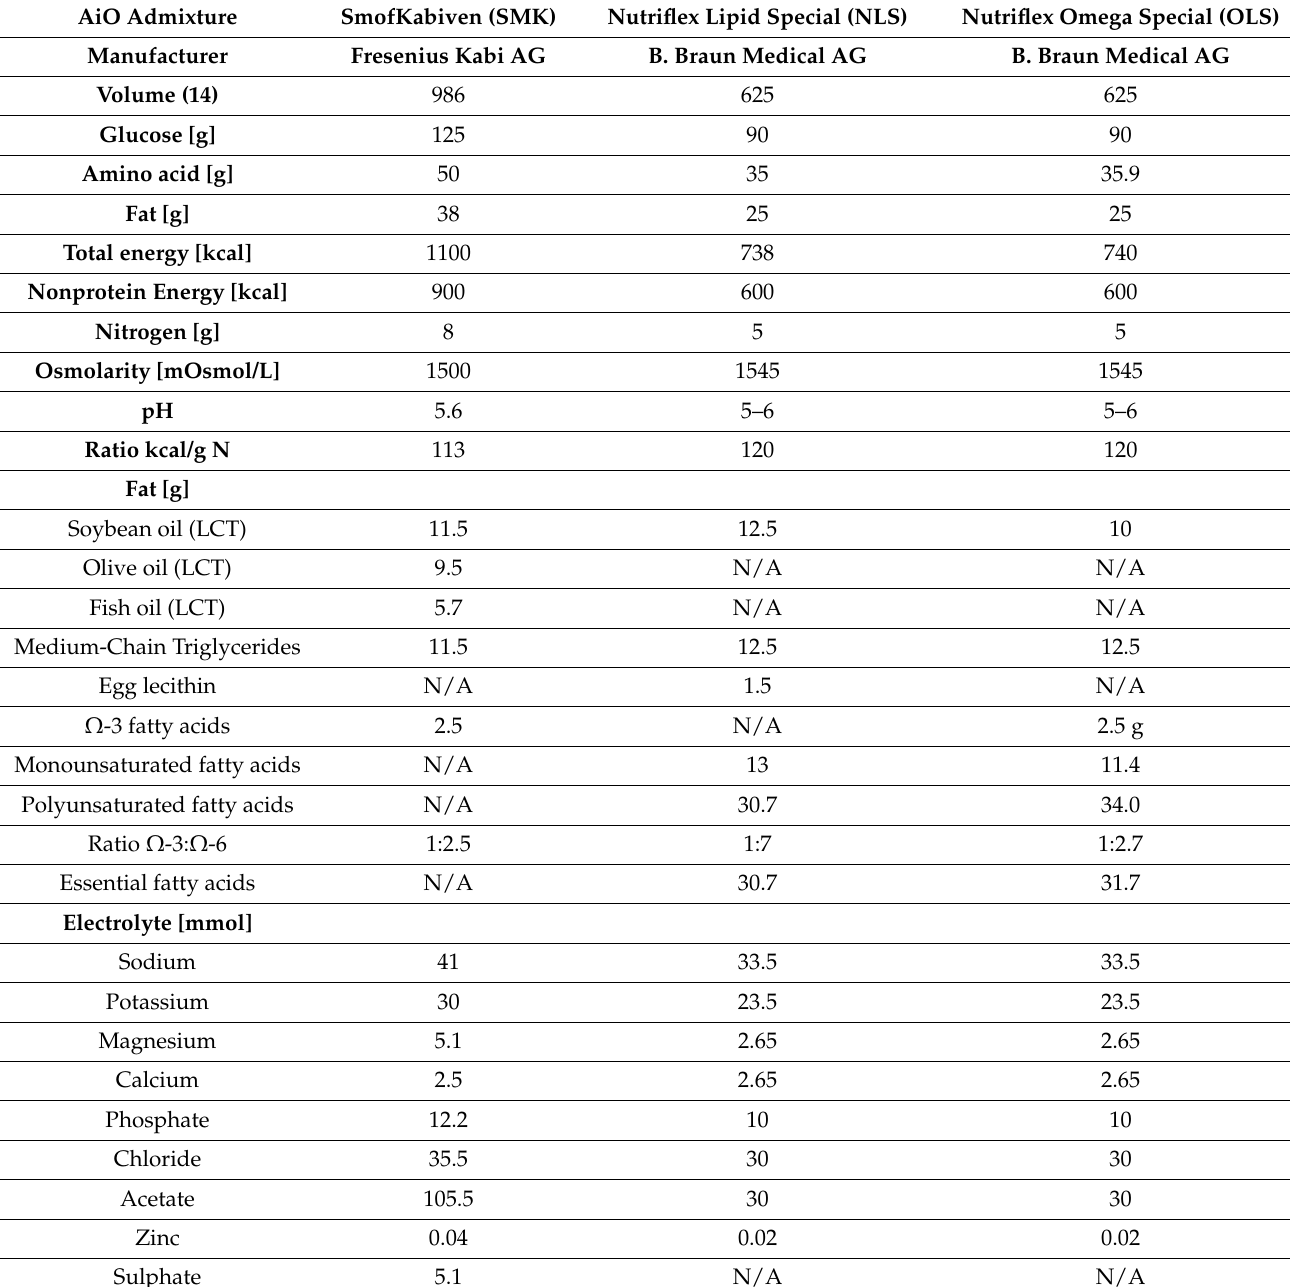
Table 1. Composition of the industrially compounded parenteral nutritional